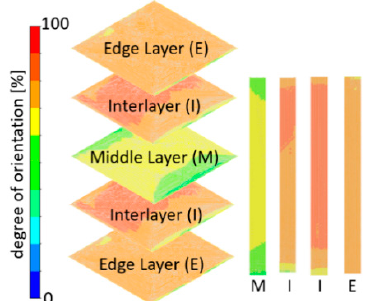
Figure 15. Fiber orientation of the fill simulation of the plate material and mapped bending specimen.